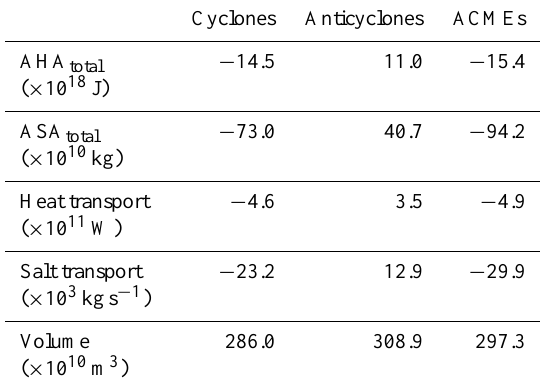
Table 4. Total available heat anomaly (AHA total ) and total available salt anomaly (ASA total ) of the composite cyclones, anticyclones, and ACMEs as well as contribution of a single eddy to the annual heat and salt transport and its mean volume. Cyclones Anticyclones